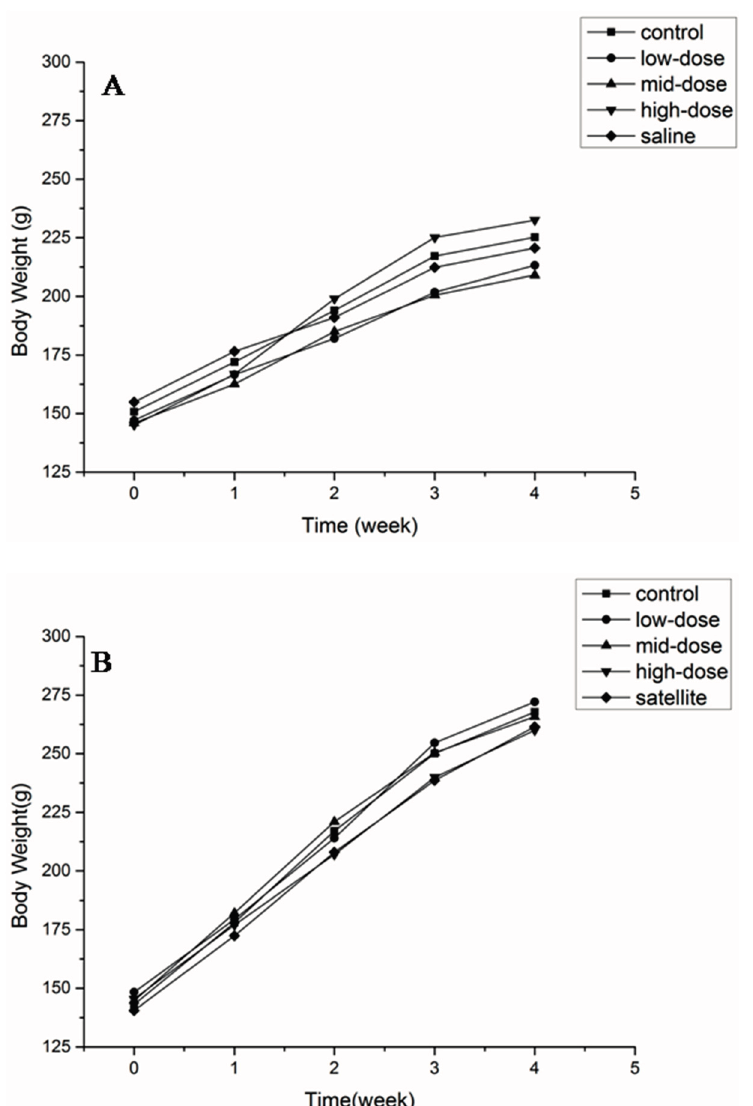
Figure 2. Body weight of female ( A ) and male ( B ) rats after a 28-day treatment with ATTM at 5, 25 and 125 mg/kg b. w. per day ( n =